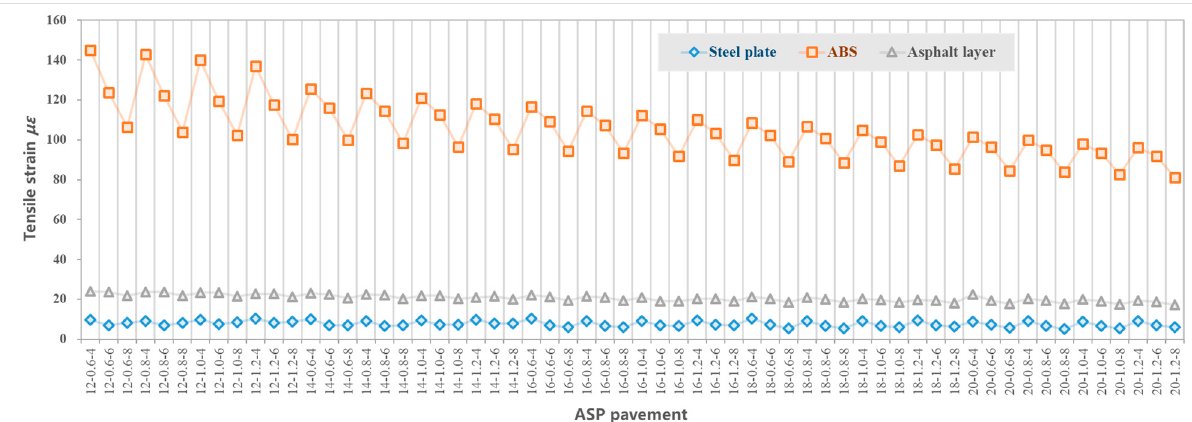
Figure 5. Tensile (horizontal) strain at the bottom of each layer of ASP pavement with different thicknesses.